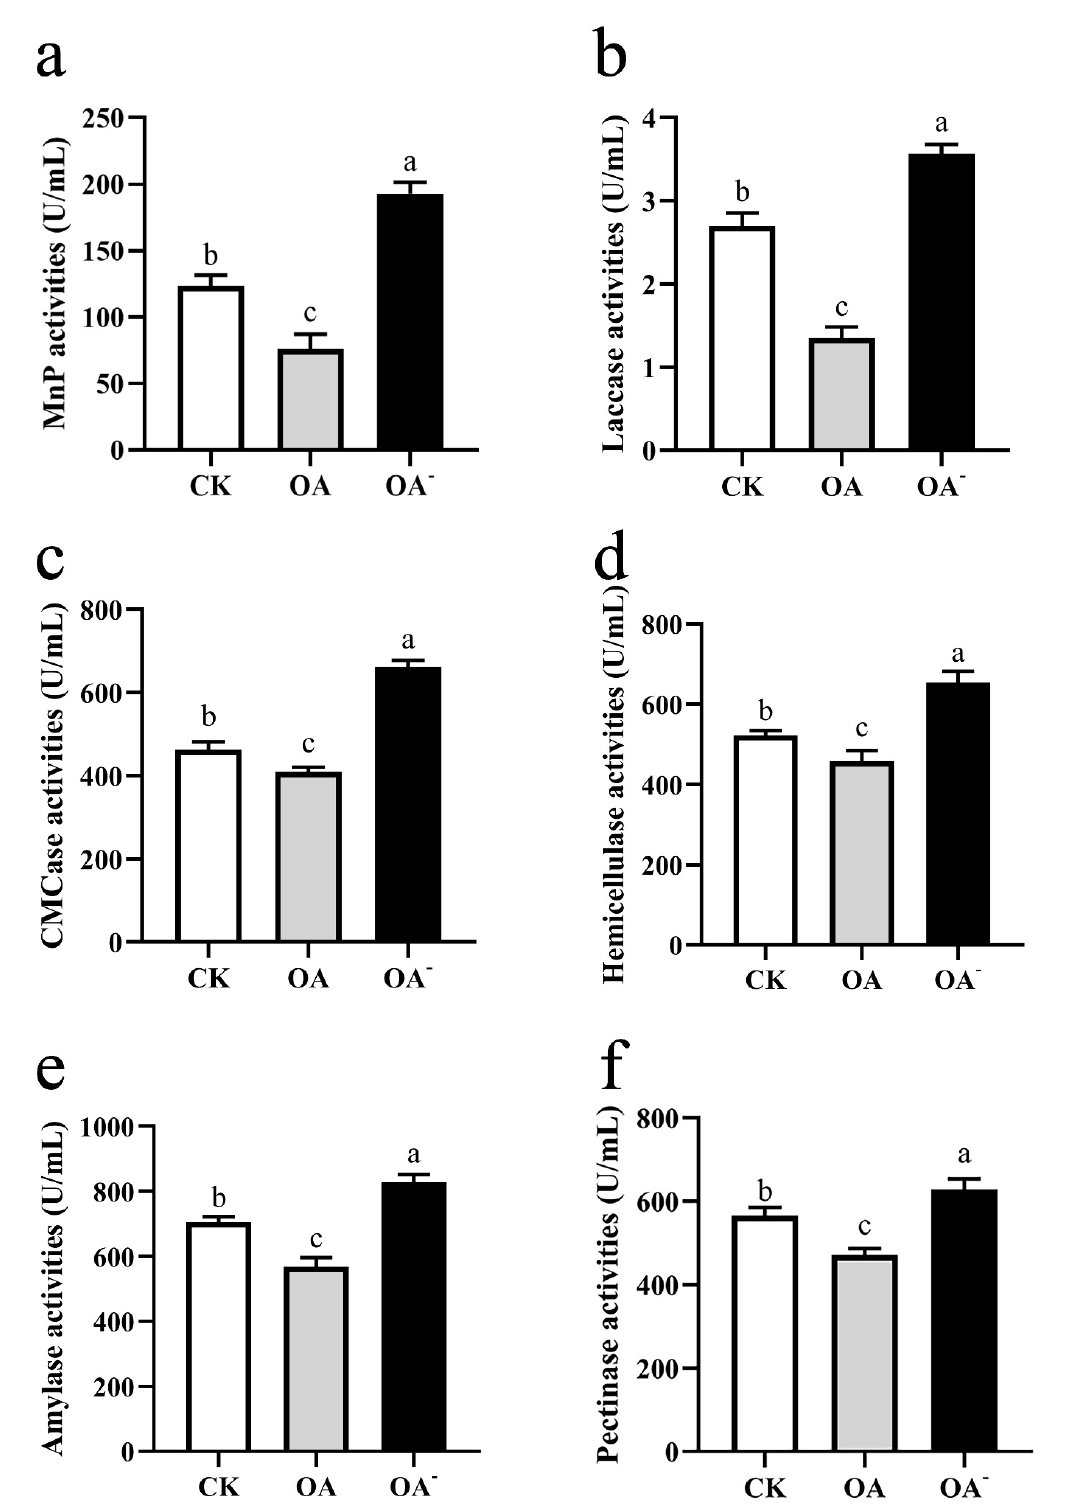
Figure 9. Activities of lignocellulose-degrading enzymes secreted by S. latifolia . Effects of different treatments (CK, OA, OA - ) on activities of ( a ) MnP, ( b ) laccase, ( c ) CMCase, ( d ) hemicellulase, ( e ) amy- lase, and ( f ) pectinase. Data were analyzed with Duncan’s ANOVA test. Error bars represent the standard deviation of three replicates. Different letters indicate significant differences between the lines ( p ď